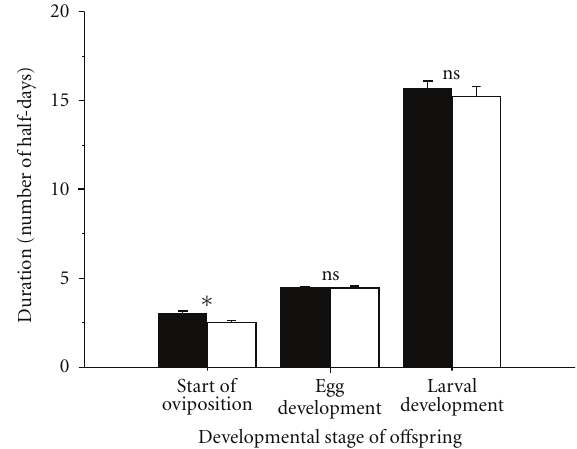
Figure 1: E ff ect of density on time elapsed until the first egg was laid (i.e., start of oviposition) as well as egg and larval development. Black bars: high-density females; white bars: low-density females. Means and SE are shown. ∗ P = 0 . 01; ns: not